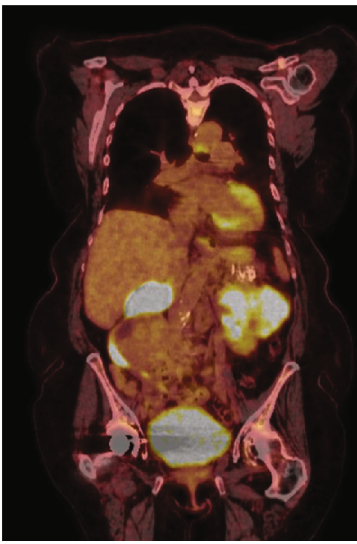
Figure 2: PET scan with right mass demonstrating moderate metabolic activity and left renal mass irregular with hypermetabolic